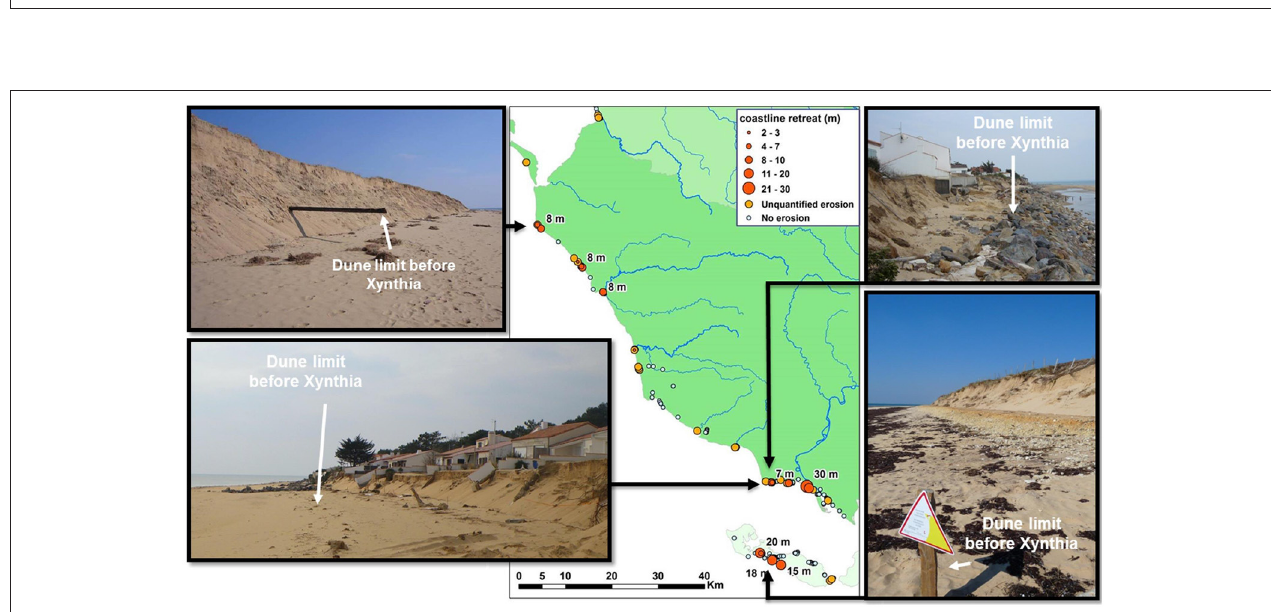
FIGURE 2 | Field evidences of sandy beaches retreats of up to 20m after the storm Xynthia in 2010 (Data: Pedreros et al., 2010; Garcin et al., 2011). The photographs present examples of indicators that allow to quantify the dune retreats. After this storm, the only retreat exceeding 20m corresponds to a breaching event. Note that the return period of water levels in the harbor of La Rochelle is estimated at about 200 year for Xynthia (Bulteau et al., 2015), and is therefore compatible with the random sample of storms considered in this study.